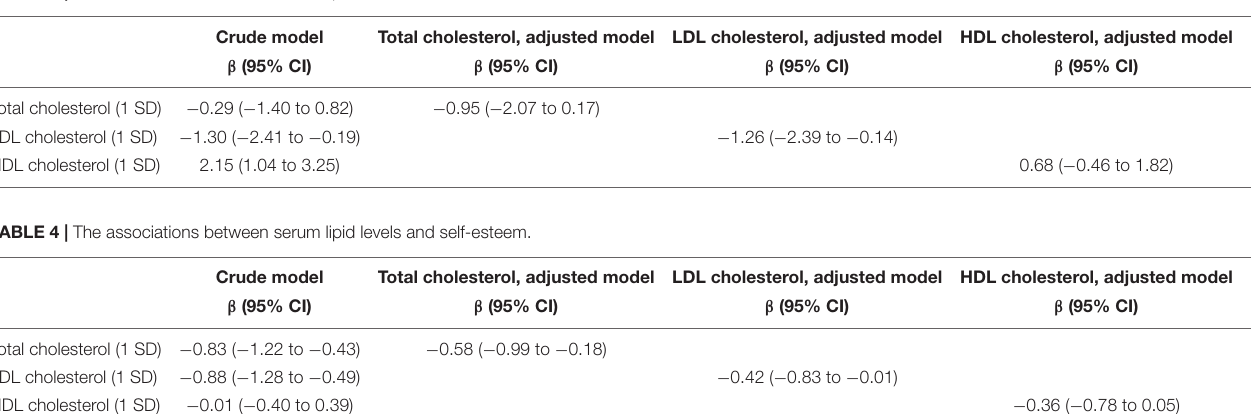
TABLE 3 | The associations between serum lipid level and resilience.